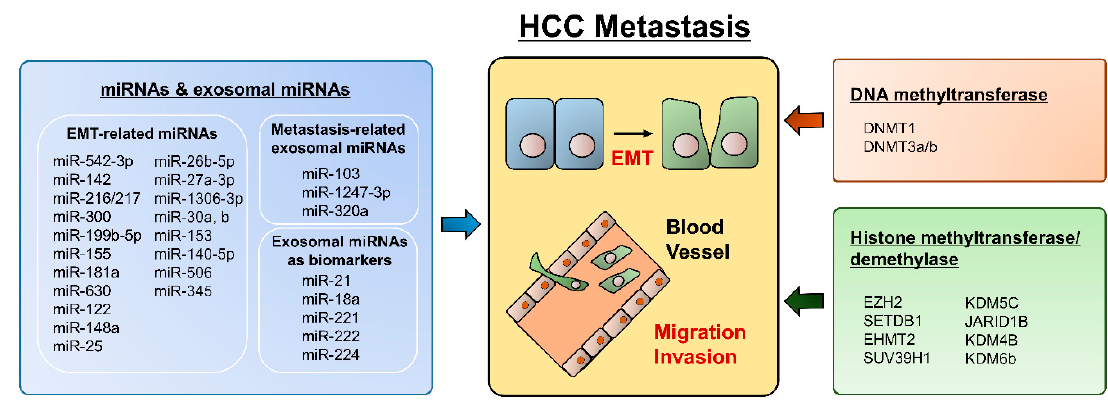
Figure 1. Summary for epigenetic regulation in HCC metastasis.